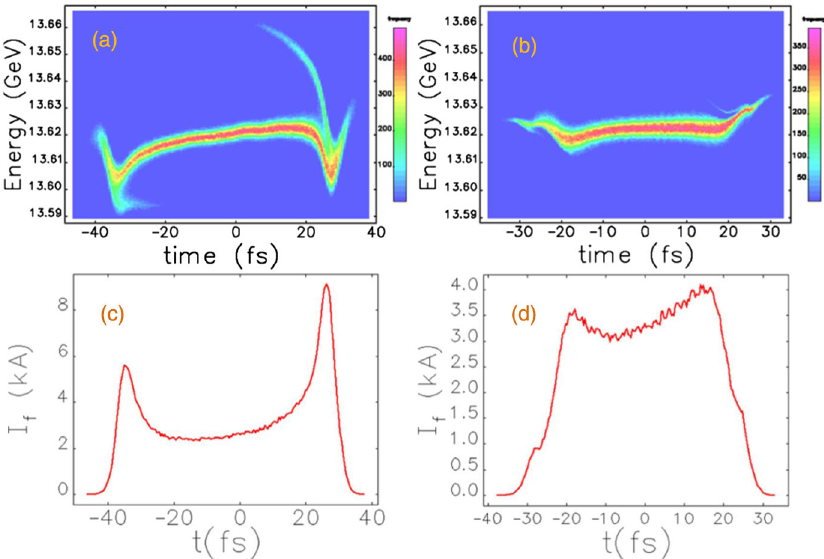
FIG. 1. Simulated electron beam phase space and current profile at the entrance of the LCLS undulator. (a) and (c) are for regular compression setup with full charge of 250 pC without collimation; (b) and (d) show the collimated beam cutting down to about 150 pC using the BC1 collimator. We see clearly the reduced current horns and flat phase space with the truncation